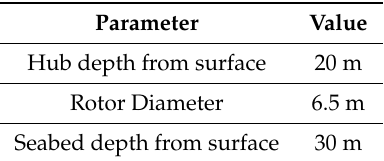
Table 2. Turbine Rotor